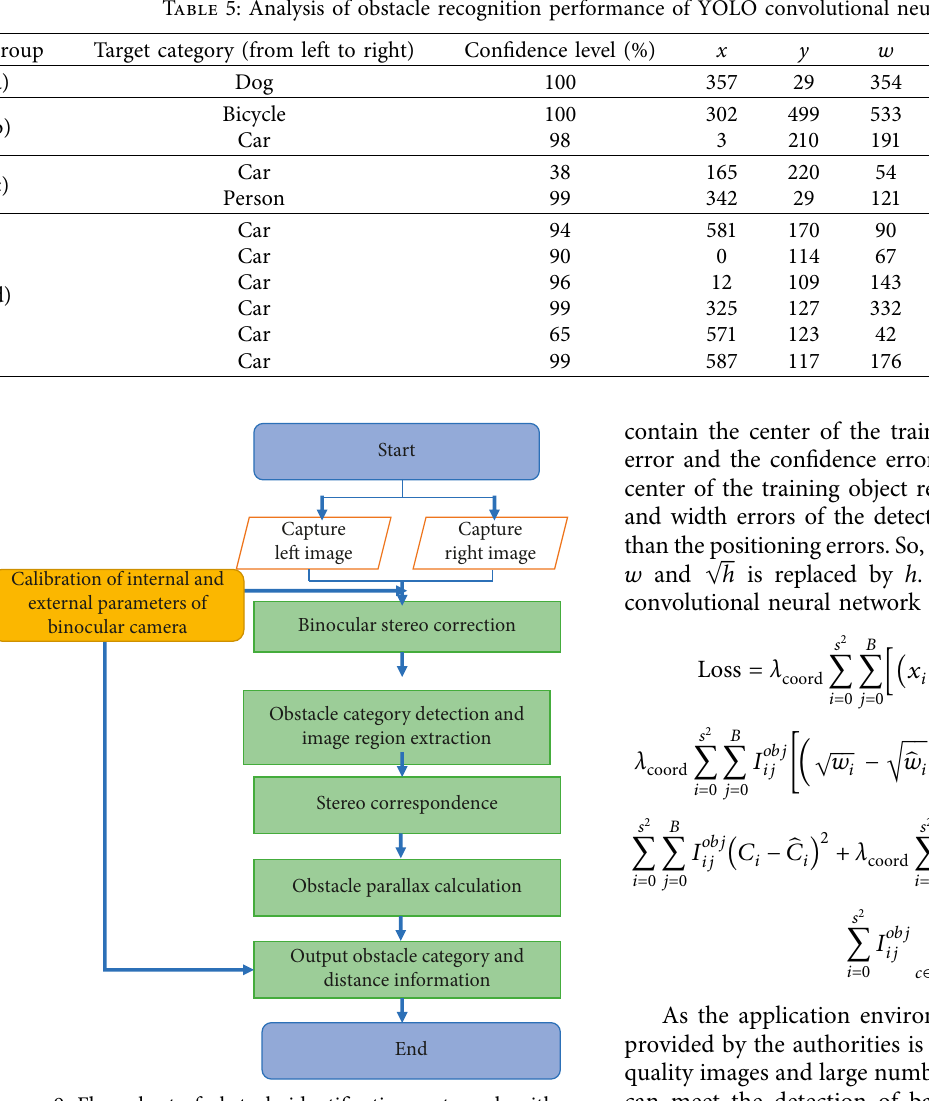
Figure 9: Flow chart of obstacle identification system